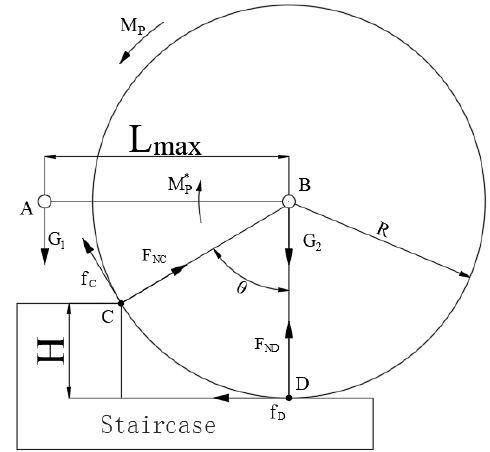
Figure 5. Force analysis of the robot climbing.